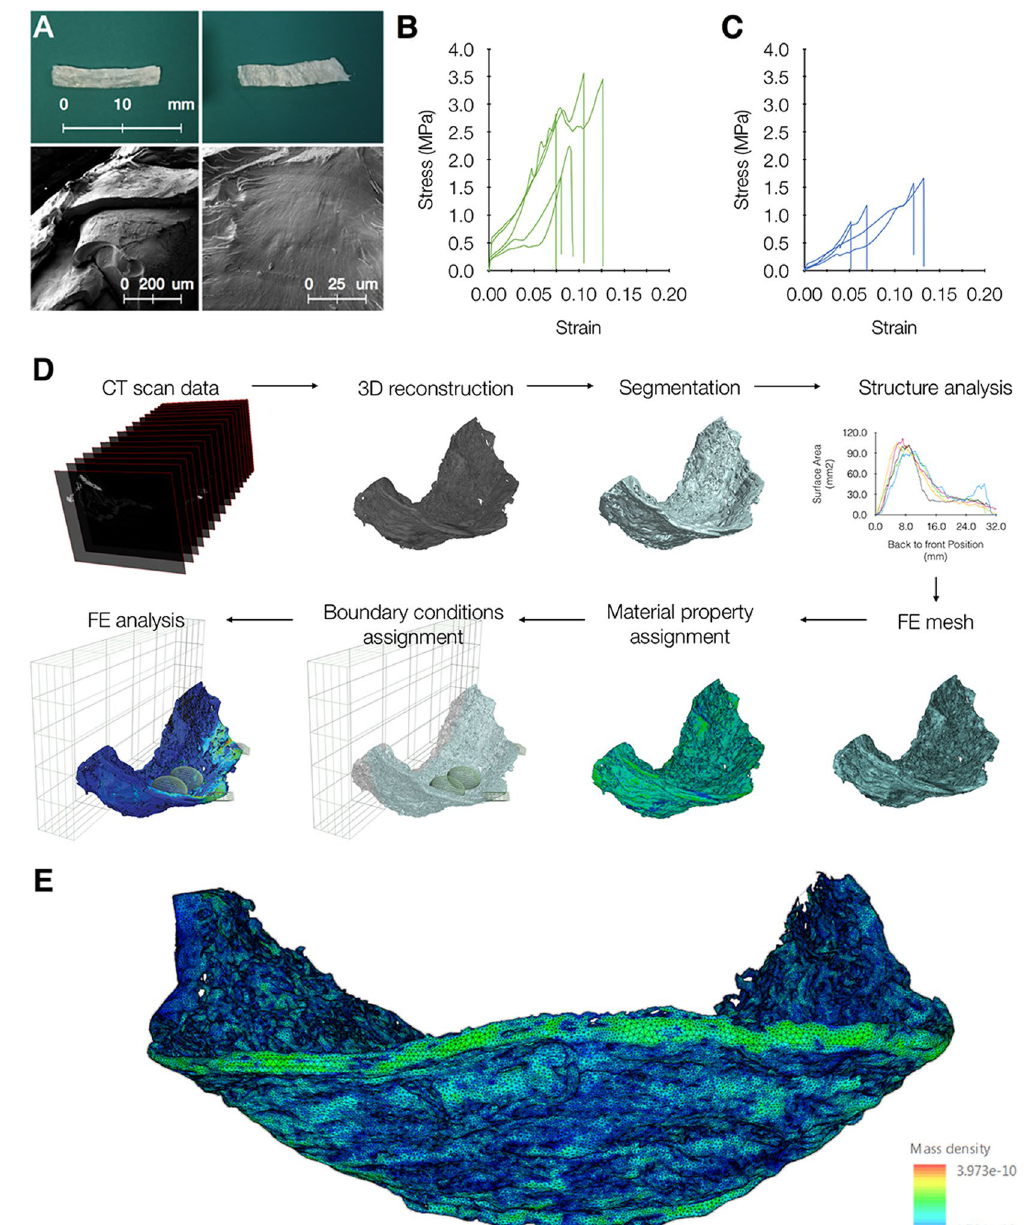
Figure 2. Mechanical characterization of nest material. ( A ) Samples of nest slices used for tensile testing. Left, slice cut along the fiber direction; right, slice cut perpendicular to the fiber direction. Bottom panel shows SEM image of fracture under tension. Fracture surfaces of both specimen types showing typical tensile fracture characteristics from representative tensile tests. Different fibres in the same nest were observed to fail at different locations, and have different characteristics. While some fibres were completely flat, with no observable features on the fracture surface, others were rougher and exhibited clear markings indicating the fiber’s crack growth direction. ( B , C ) Altogether, these tests yielded a mean breaking stress (peak stress in the stress-strain curve) of 2.75 ± 0.79 MPa and a mean elastic modulus of 155 MPa. ( D ) Workflow for nest reconstruction, from computer tomography (CT) scans to the finite element (FE) model: μ CT scanned image files imported into ScanIP. Background image data segmented and analyzed within scanIP. + FE module within ScanIP is used for defining contact entities and generate the FE mesh. FE mesh imported into Abaqus for assignment of material properties and boundary conditions. Finally showing + FE Free Mesh after analysis in Abaqus. ( E ), A high- resolution finite-element (FE) model of the nest created based on the 3D model and the mechanical measurements, with material density represented by color scale (blue, least dense; green, most dense). Shown is the FE model of one of the studied